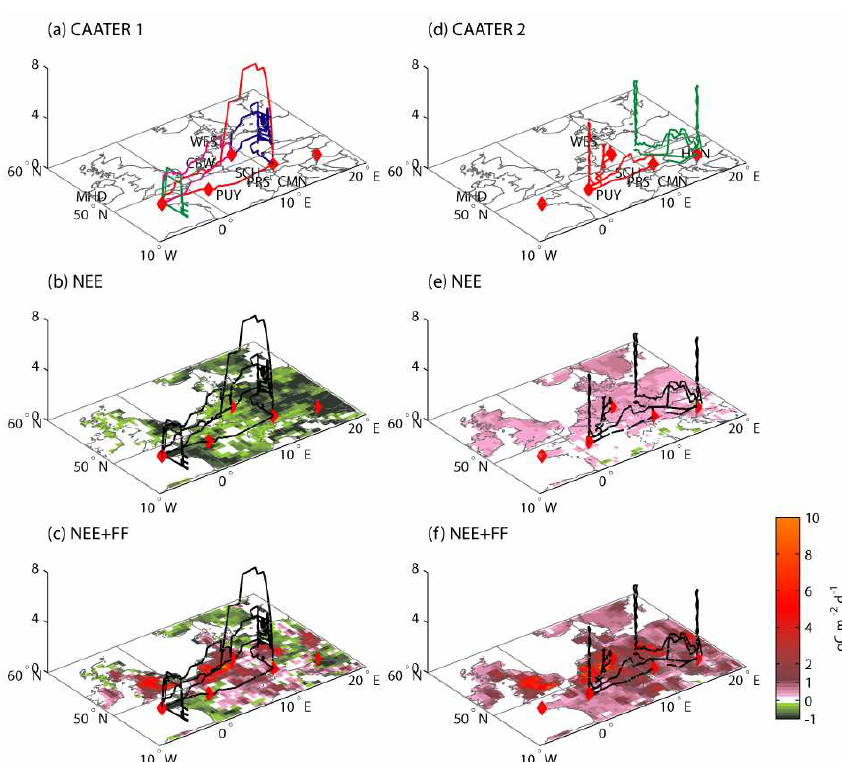
Fig. 1. Averaged flux maps (for the days of the campaigns) and flight patterns (red: 1st day, green: 2nd day, pink: 3rd day, blue: 4th day of the campaigns) according to latitude, longitude and altitude (in km). Net Ecosystem Exchange (NEE) fluxes are from ORCHIDEE and fossil fuel (FF) fluxes from Andres et al. (1996) (left: CAATER-1, right: CAATER-2). Oceanic fluxes are from Takahashi et al. (1999) and are almost zero therefore do not appear in the